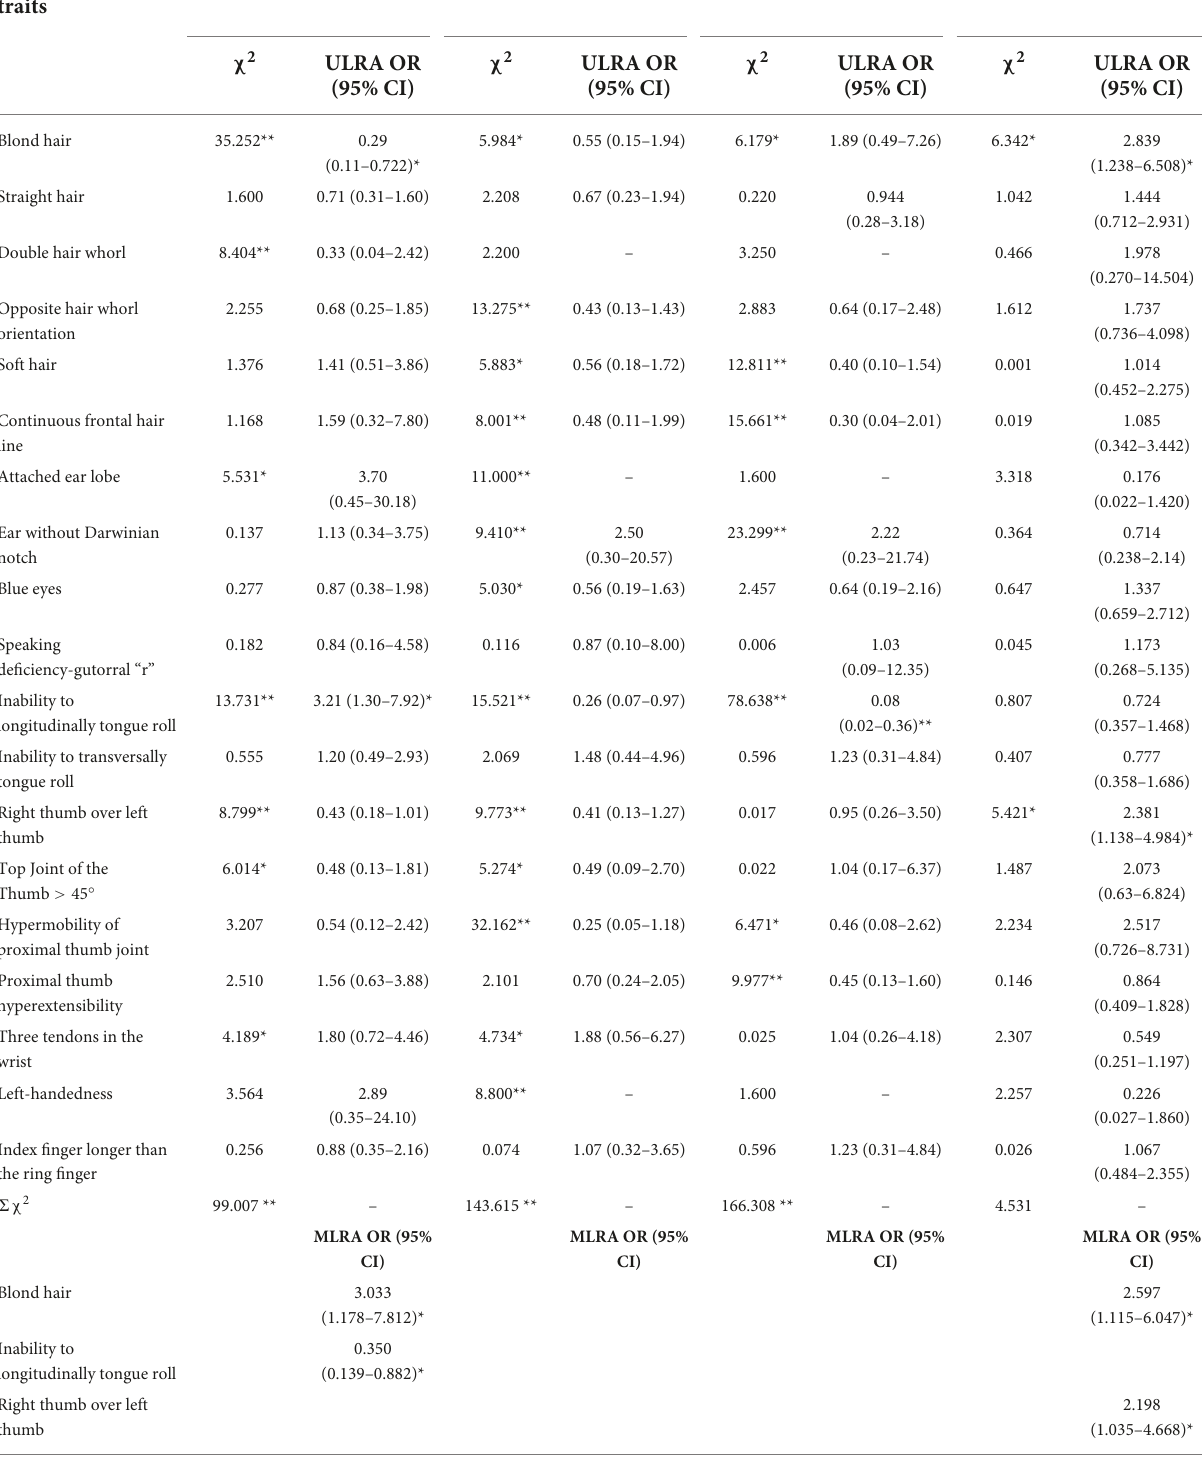
TABLE 3 Statistical interpretation of observable recessive human traits frequencies among tested